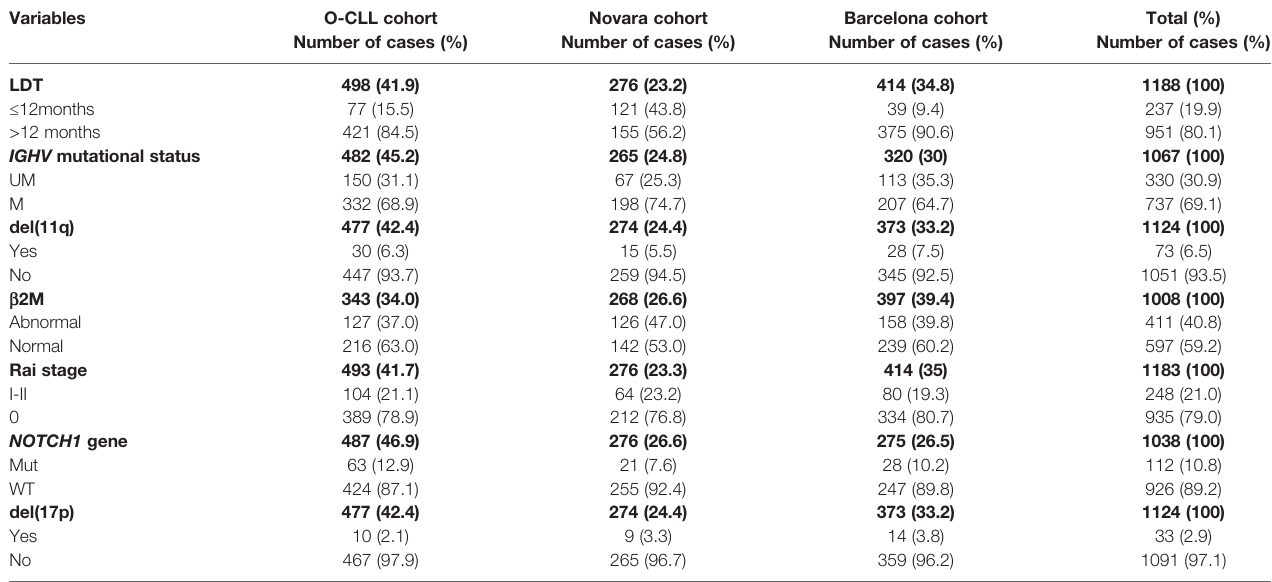
TABLE 4 | Comparison of the clinical and biological variables of O-CLL (training), Novara and Barcelona (validation) cohorts resulted signi fi cantly associated to time to fi rst treatment in the multivariate models. Variables O-CLL cohort Novara cohort Barcelona cohort Total (%) Number of cases (%) Number of cases (%) Number of cases (%) Number of cases (%)